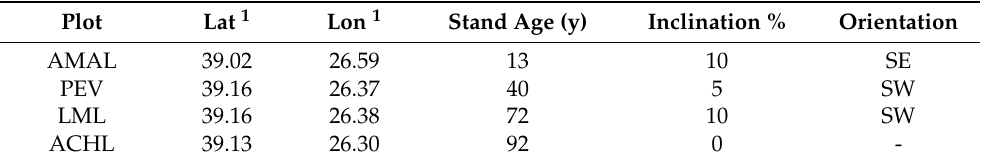
Table 1. Characteristics of the study plots. AMAL is the 13 year-old plot, PEV is the 40 year-old plot, LML is the 72 year-old plot and ACHL is the 92 year-old